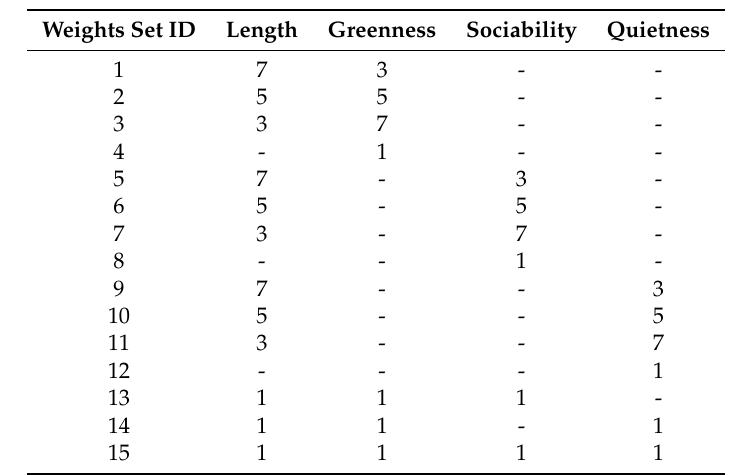
Table 4. Sets of factor weights applied to generate alternative routes for the one-thousand randomly generated